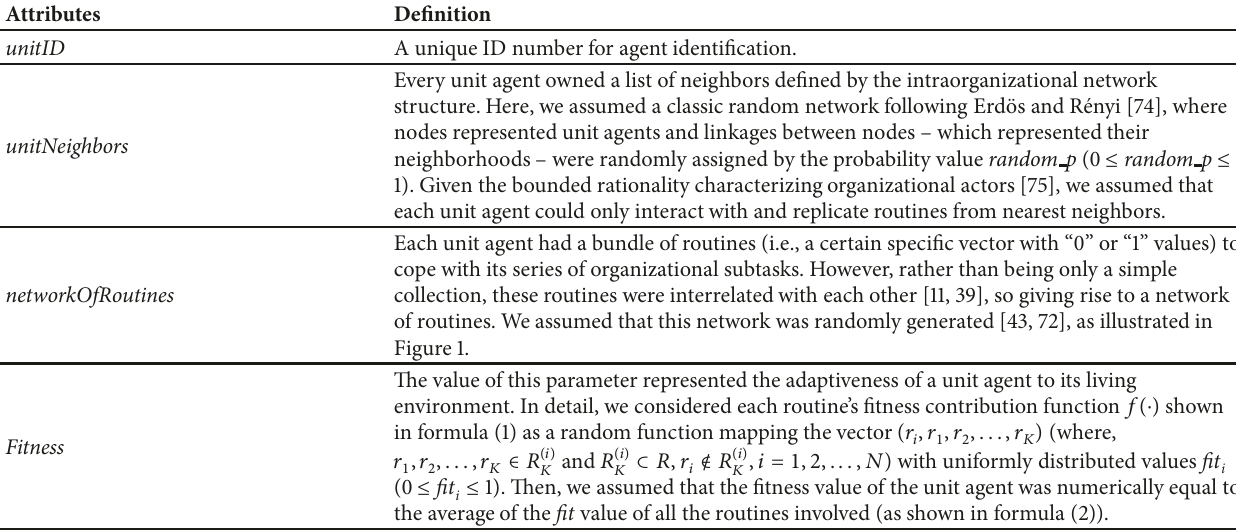
Table 1: Definition of agent